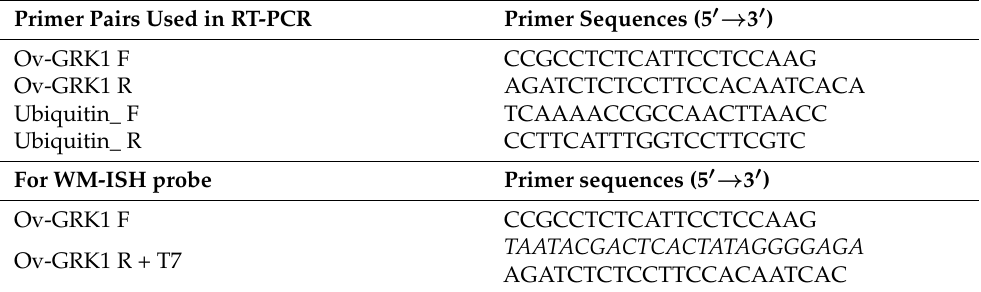
Table 1. Primers used in this study. Primer Pairs Used in